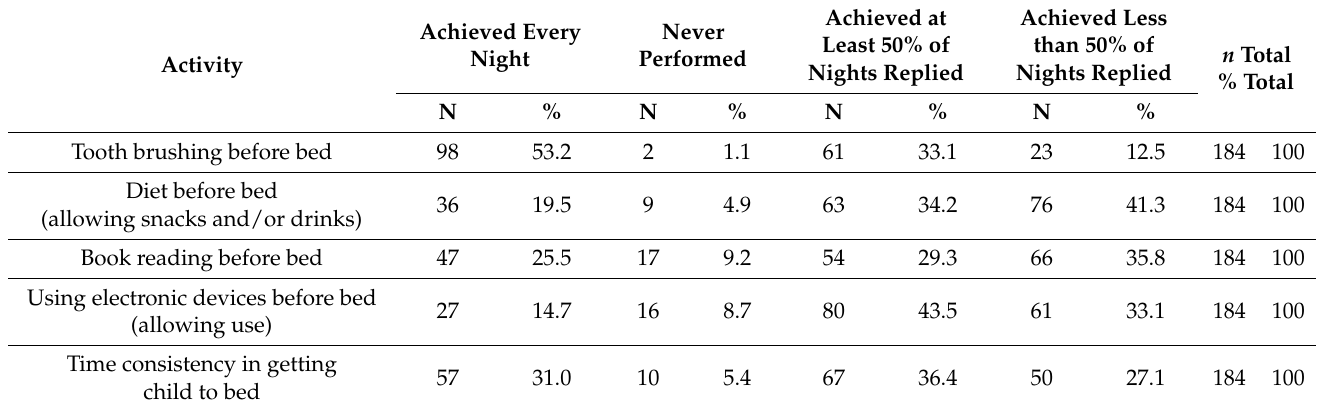
Table 2. Overview of each targeted activity as part of the bedtime